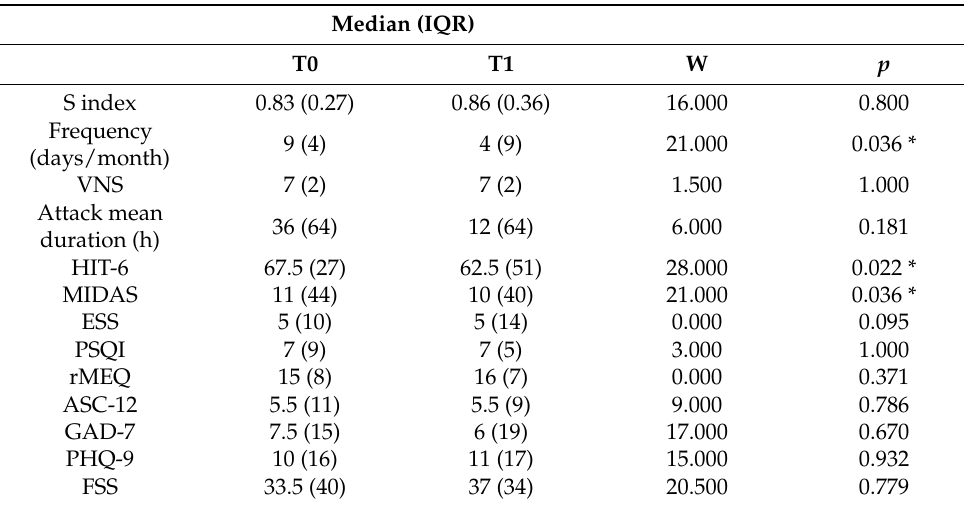
Table 5. Comparative analysis of S index and data from clinical assessment, patient’s diary, and questionnaires between T0 and follow-up (T1).